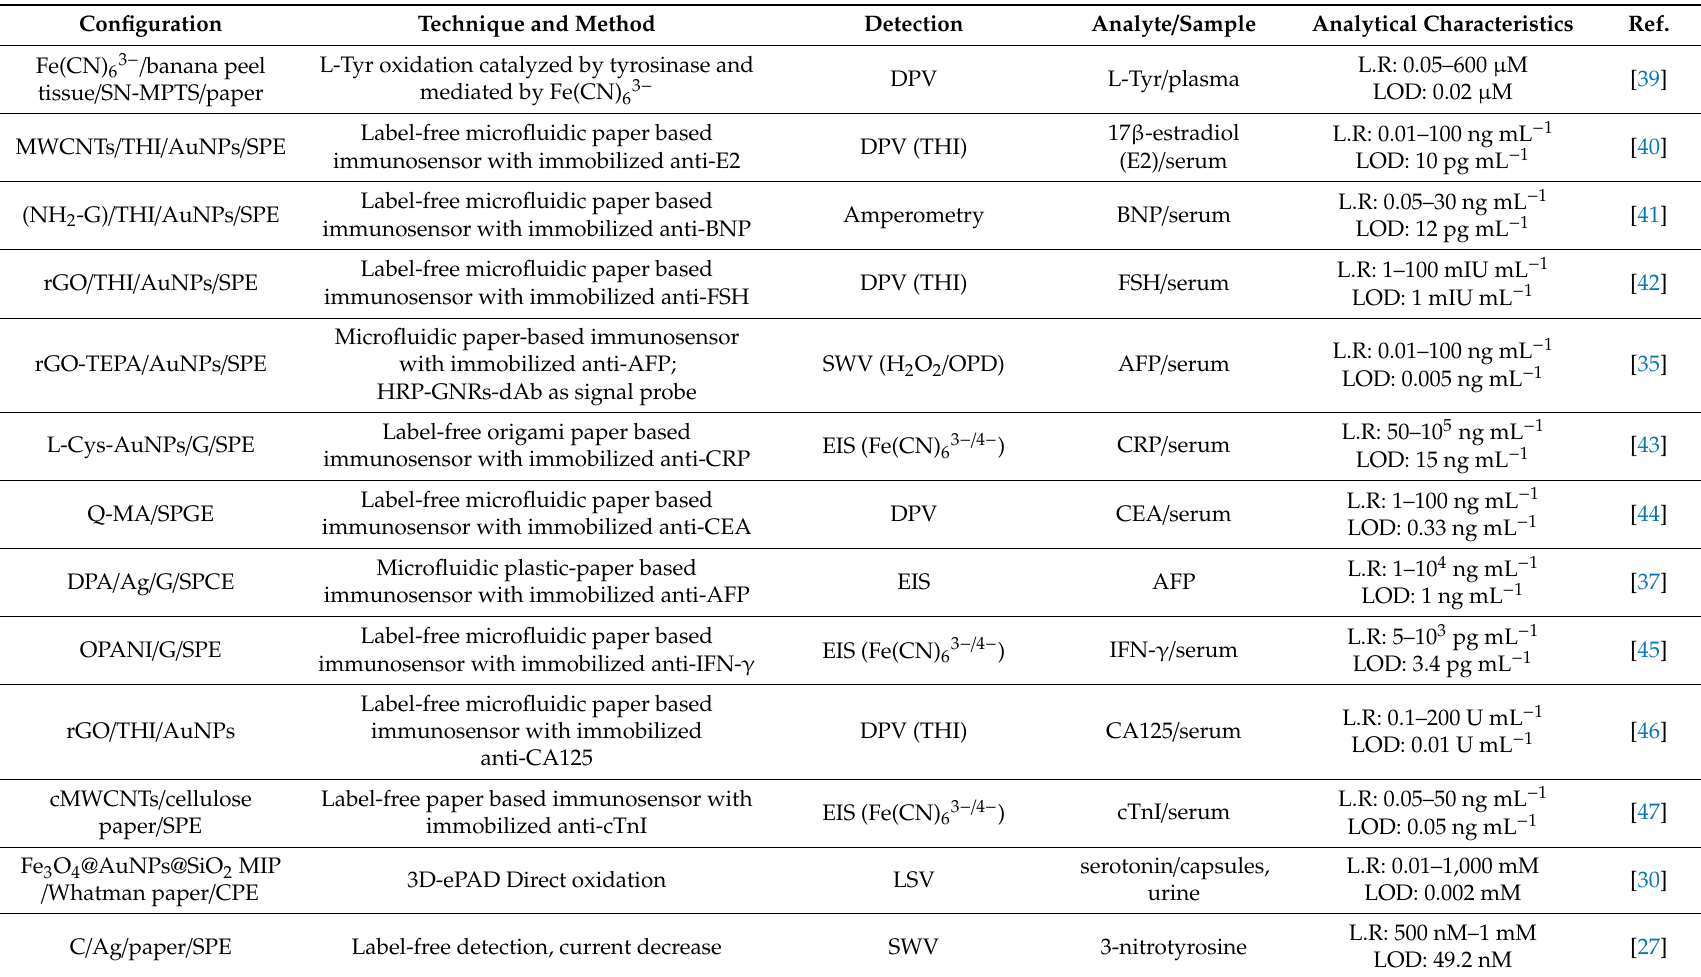
Table 2. Screen-printed paper electrochemical (bio)sensors for clinical